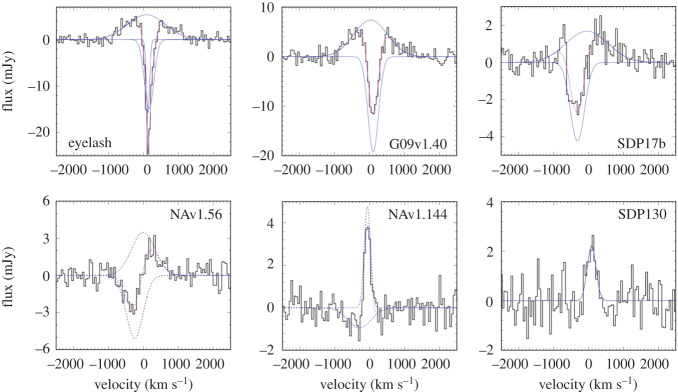
Detection of the methylidyne cation, CH+, in both absorption and emission in six z ∼ 2.5 lensed starbursts. The combination of ALMA’s sensitivity and strong gravitational lensing has allowed this molecule to be detected in the high-redshift universe for the first time, highlighting the role of turbulence in the gas reservoirs of these galaxies. Figure reproduced from Falgarone et al. [306].